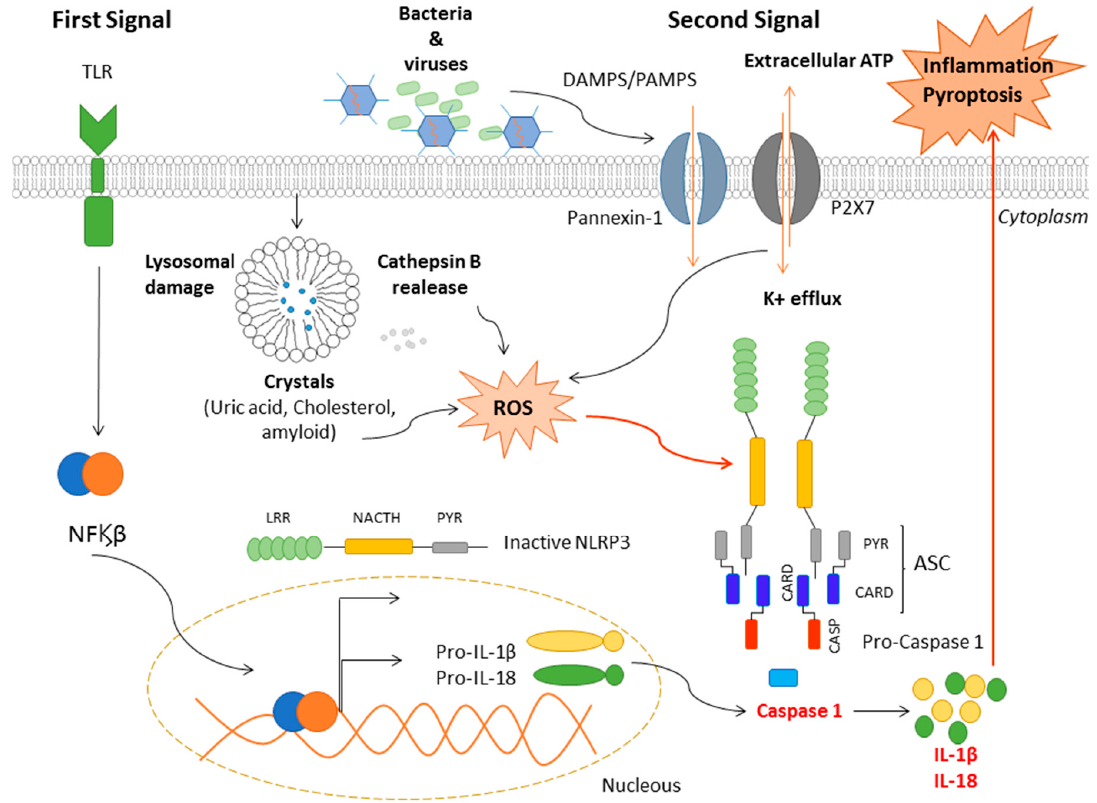
Figure 2. Mechanisms of NLRP3 activation. There are two consecutive signals that are needed in order to have an activated inflammasome. The first is responsible for the activation of the NF Ϗ β pathway and upregulating inactive pro-inflammatory cytokines such as IL-1 β and IL-18, as well as transcribing NLRP3 proteins. The second signal carries out the recruitment of apoptosis-associated speck-like protein (ASC) and pro-caspase-1 and the NLRP3 oligomerization. Then, the pro-inflammatory cytokines are activated and released into extracellular space. Within the NLRP3 ligands, extracellular ATP, K + efflux and Ca +2 trigger the inflammasome through the Pannexin-1, P2 × 7 and TRMP2 receptors. Exogenous particulate matter destabilizes and damages lysosomes and thus, numerous inner enzymes such as cathepsin B are released into the cytoplasm and activate the NLRP3. High levels of Reactive Oxygen Species (ROS) cause the dissociation of TNXIP from thioredoxin (TRX) and binding to NLRP3.